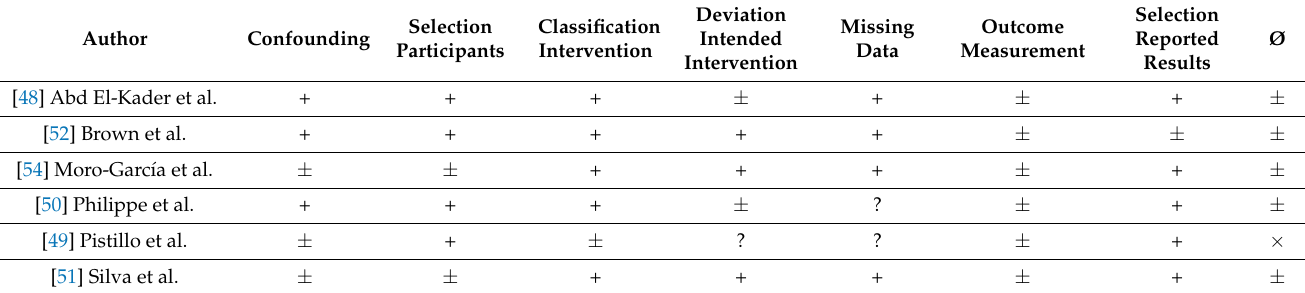
Table 8. Risk of bias assessment with the ROBINS-I tool for the included studies ( n = 6).